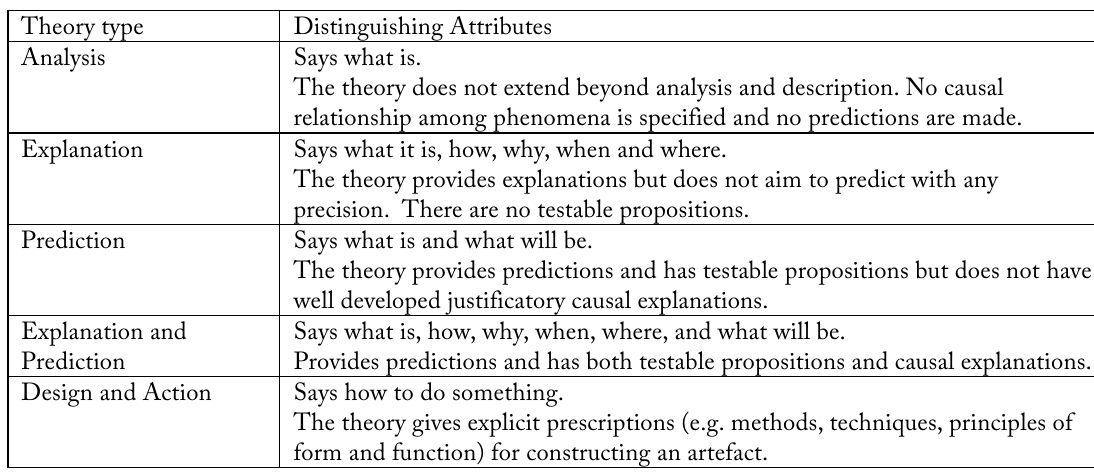
Table 1 Theory types in Information Systems (quoted from Gregor